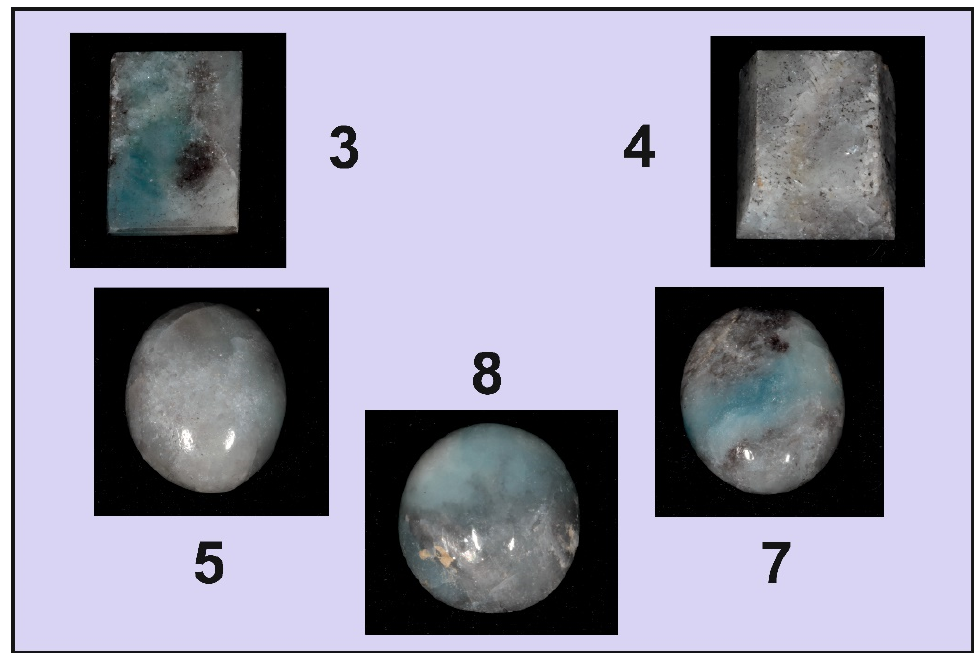
Figure 8. Another five cabochon ‐ cut gems analyzed in this work, from the right side of the valley; samples 3 (14 mm × 11 mm × 5 mm); 4 (13 mm × 11 mm × 4 mm); 5 (17 mm × 13 mm × 4 mm); 7 (13 mm × 10 mm × 4 mm); 8 (19 mm × 14 mm × 6 mm)